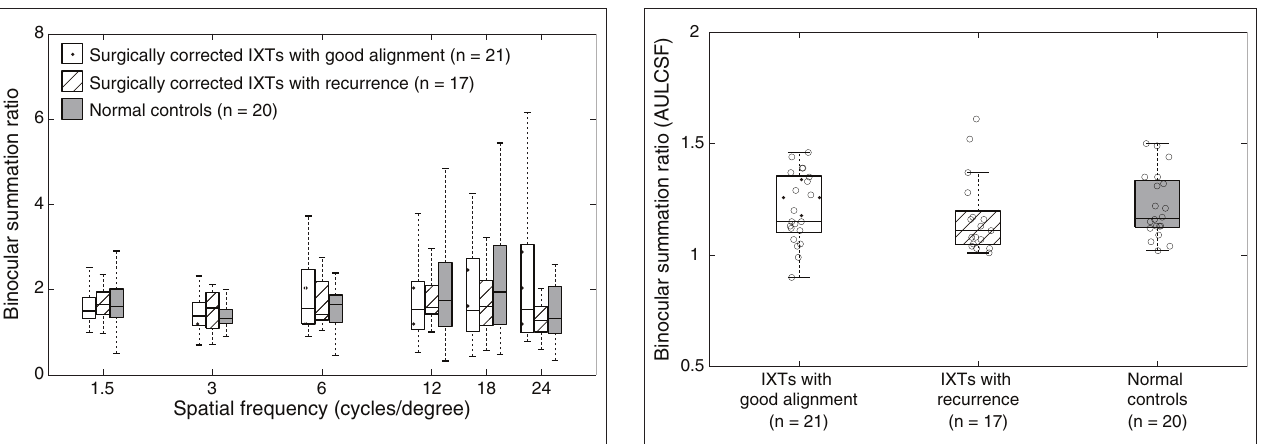
FIGURE 4 | Boxplots of binocular summation ratio at AULCSF. Boxplots of binocular summation ratio among surgically corrected IXT patients with good alignment, recurrence and normal controls at